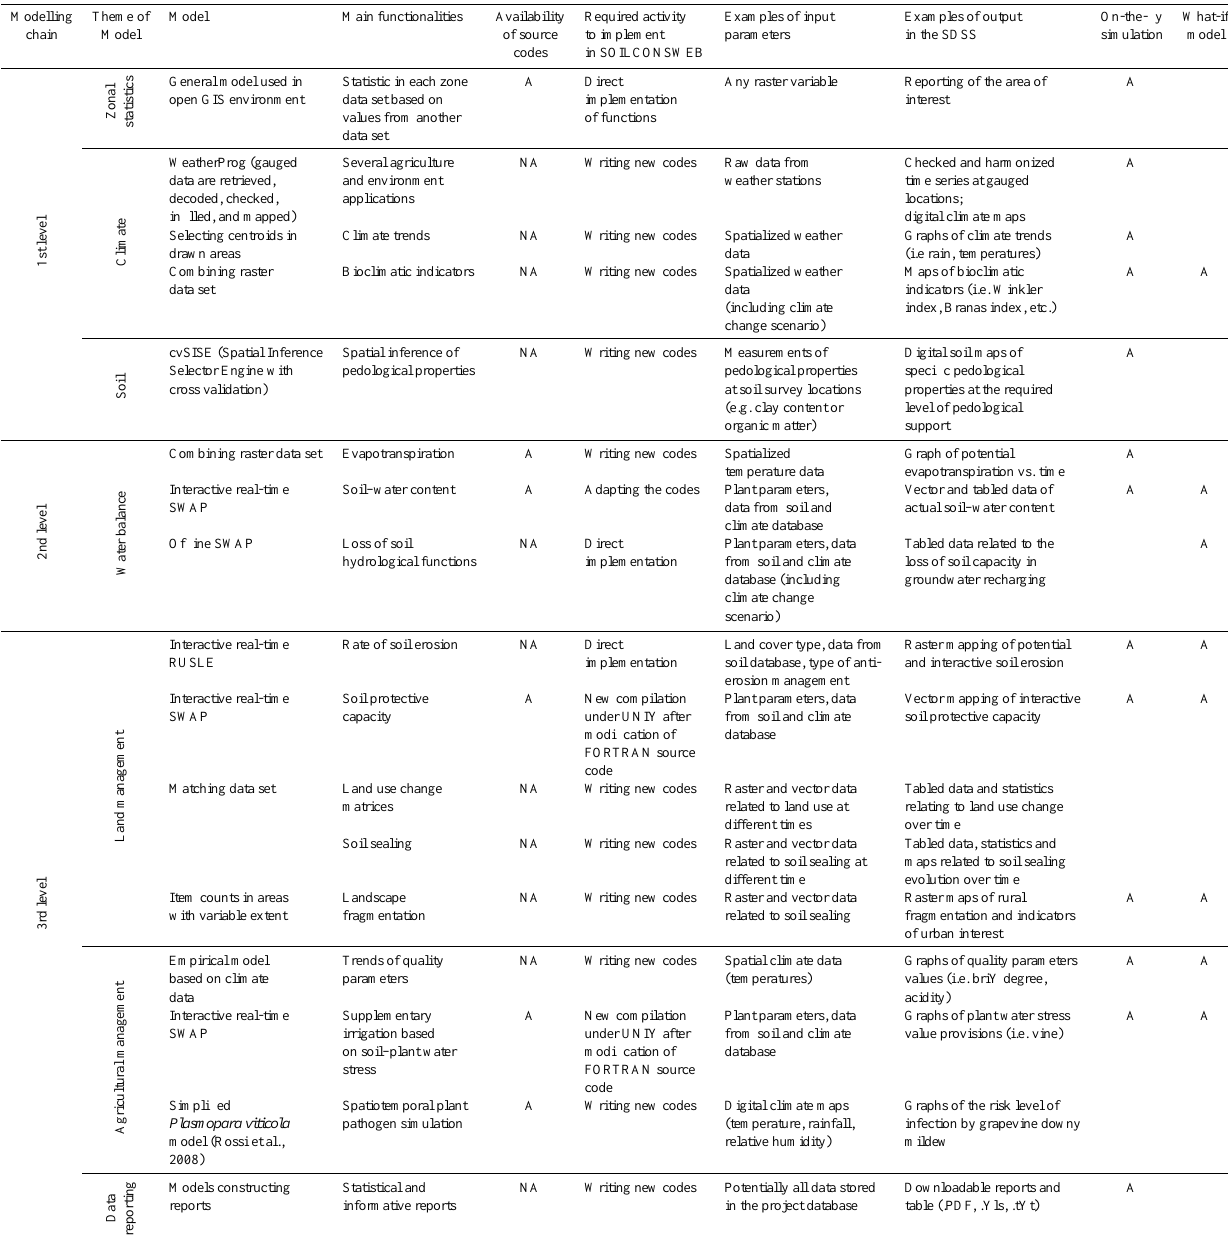
Table 3. Modelling details in SOILCONSWEB-GCI. “A” stands for “available”; “NA” stands for “not available”. Modelling Themeof Model